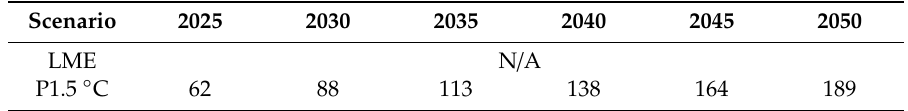
Table A15. CO 2 costs assumptions in di ff erent scenarios represented in US $ / tCO 2 . Data based on Reference